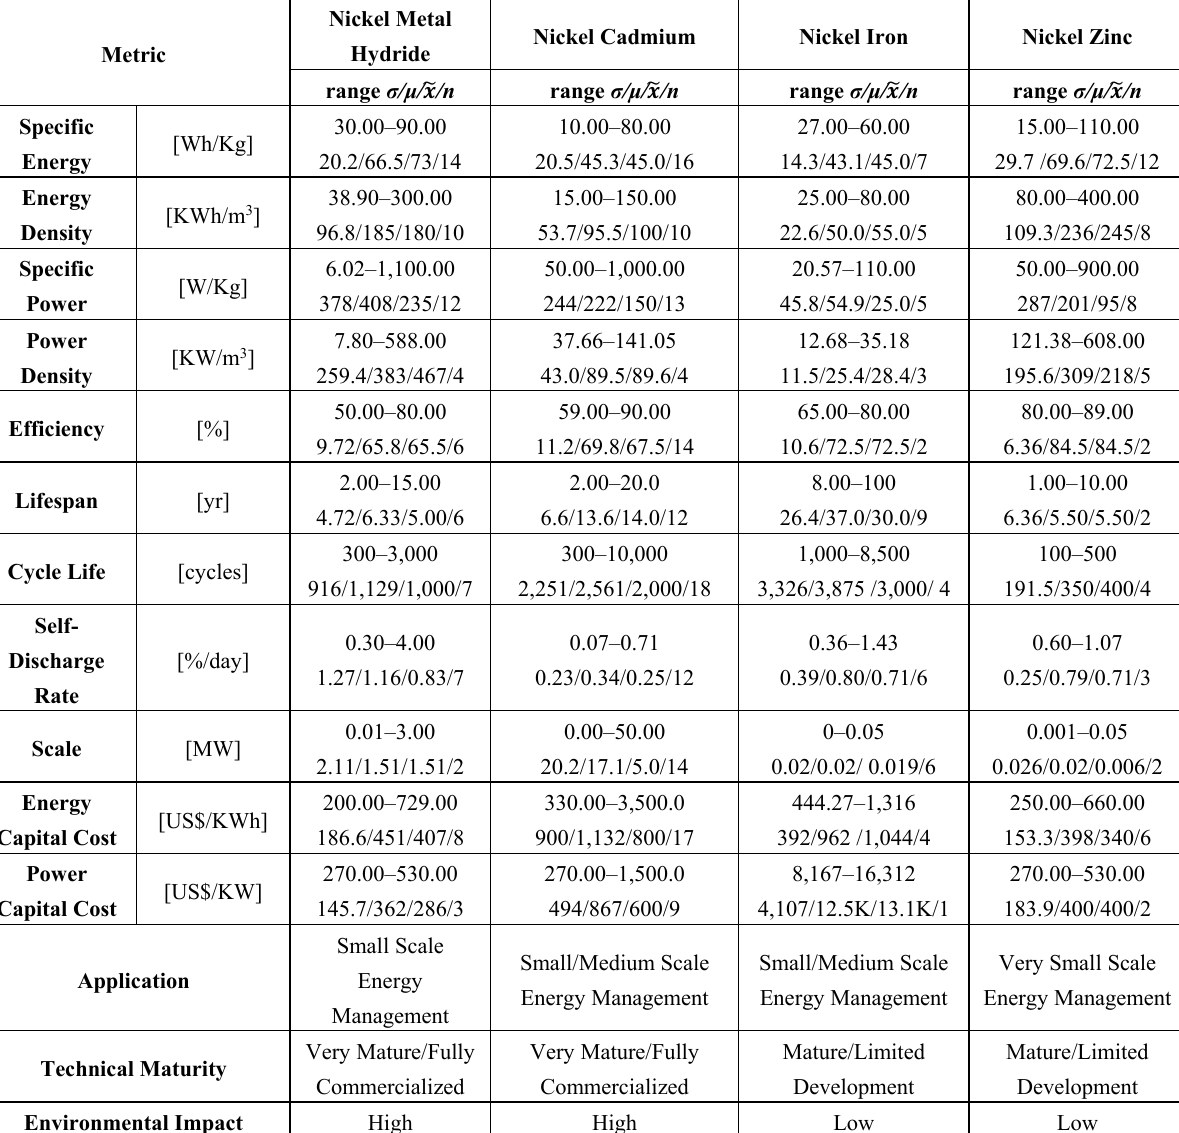
Table 5. Comparing typical chemical batteries based on fourteen different metrics. Data obtained or calculated from multiple sources